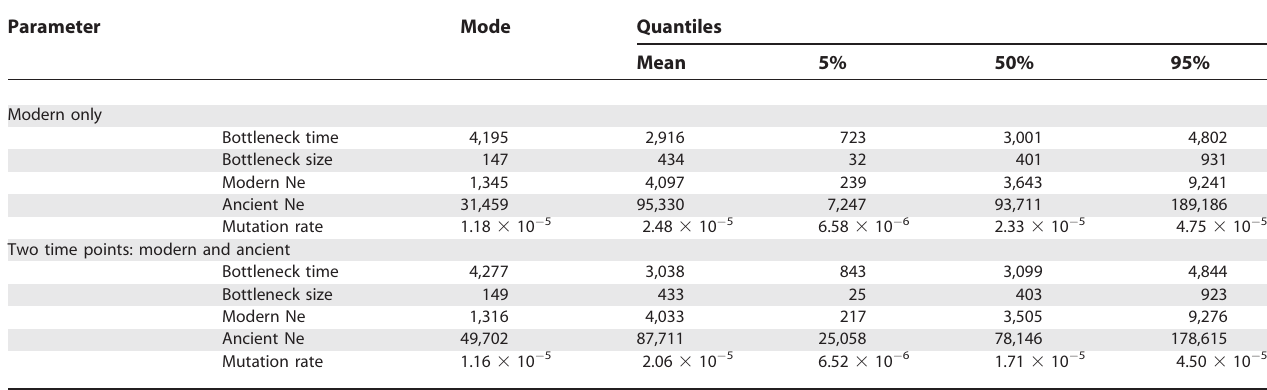
Table 3. Mode, Mean, and Quantile Values of the Prior and Posteriors for the Demographic and Marker Parameters of the Modern Only and Two–Time Points